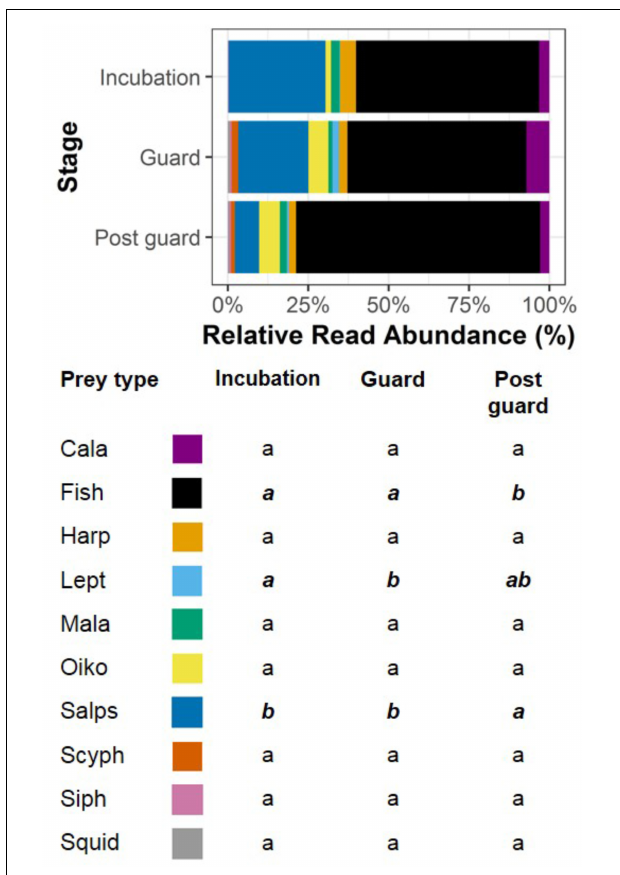
FIGURE 5 | The relative read abundance (RRA) (%) of the 10 most common taxa in fecal samples over breeding stages. The percentages for each taxon over stages are accompanied by a compact letter display indicating significant differences between breeding stages. Breeding stages with the same letter are considered similar to each other, and months with different letters are considered significantly different from one another. Significant differences are also denoted by bold, italic text. Note that January was not incorporated in analyses due to insufficient sample size. Taxa are Cala = Calanoids, Fish, Harp = Harpacticoids, Lept = Leptothecans, Mala = Malacostracans, Oiko = Oikopleurids, Salps, Scyph = Scyphozoans, Siph = Siphonophores, and